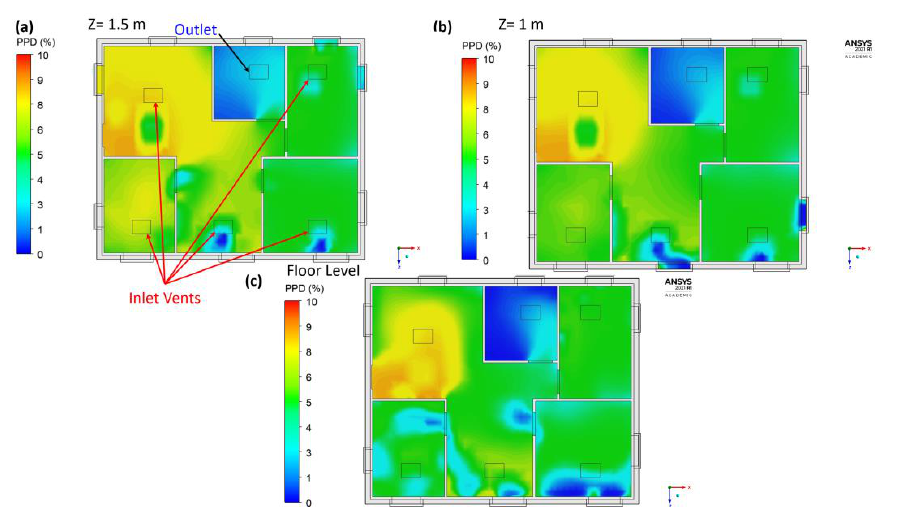
Figure 11. The predicted percentage dissatisfied (PPD) profiles distribution for the house (top view) using ASHRAE 55-2017 inlet temperature 25 ℃ at different heights ( a ) 1.5 m, ( b ) 1 m, and ( c ) the (finished) floor.